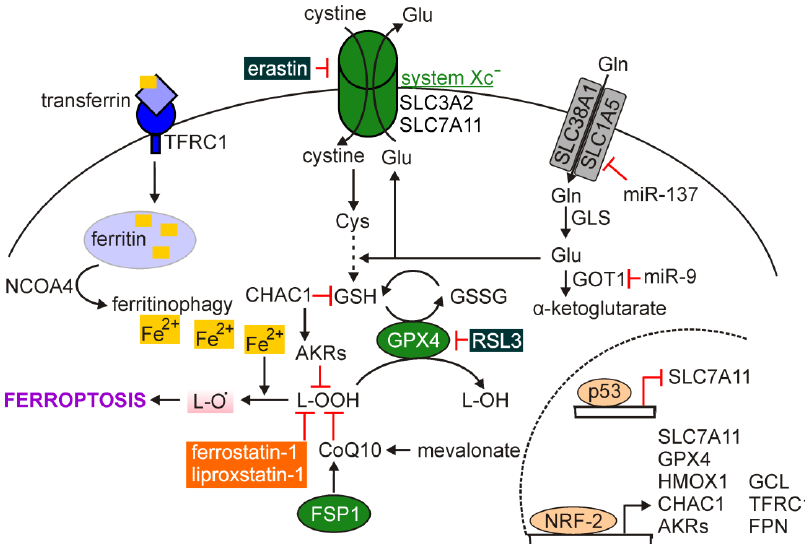
Figure 4. Regulation of ferroptosis. Transmembrane system X C¯ composed of SLC3A2 and